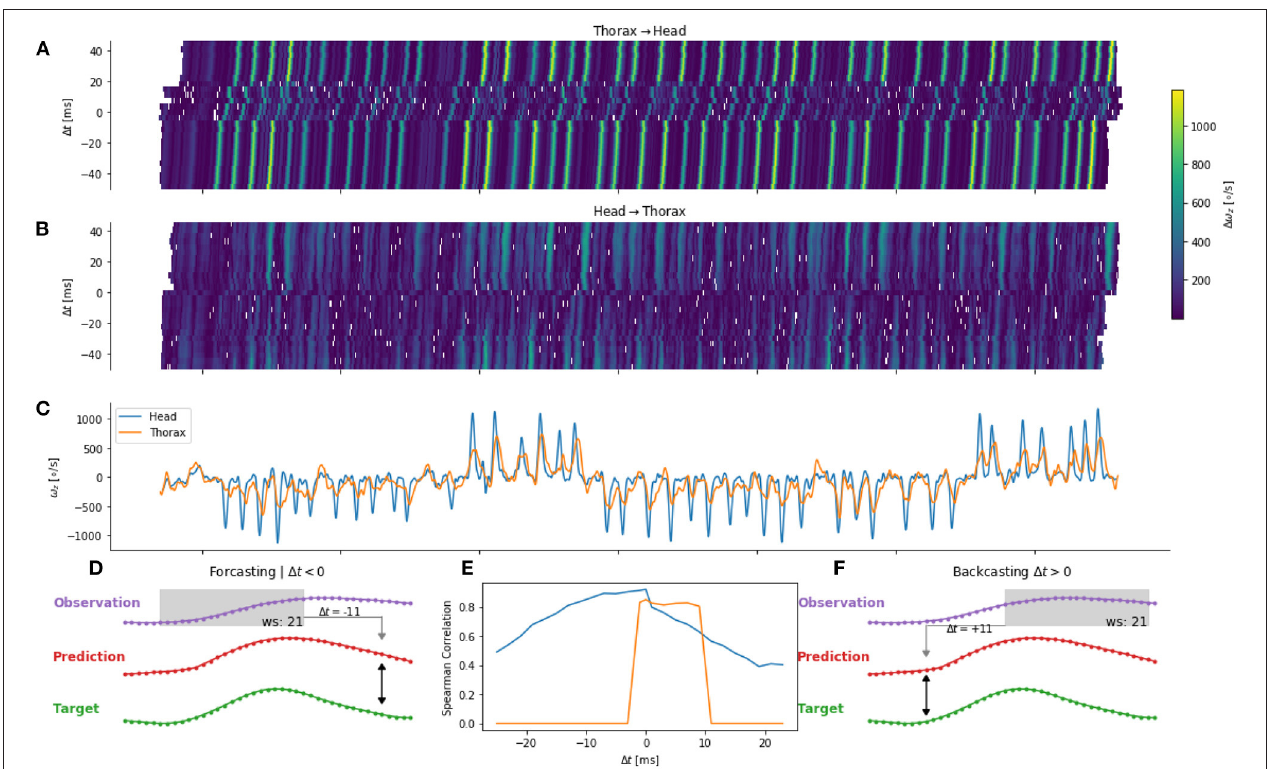
FIGURE 7 | Error for one flight (validation set) for thorax to head (A) and head to thorax (B) prediction. Time course of the head and thorax angular velocity (C) are shown in blue and orange, respectively. (D,F) Example of a positive and negative shift of ± τ 11 time steps of the observation. (E) Correlation between target and prediction for different temporal